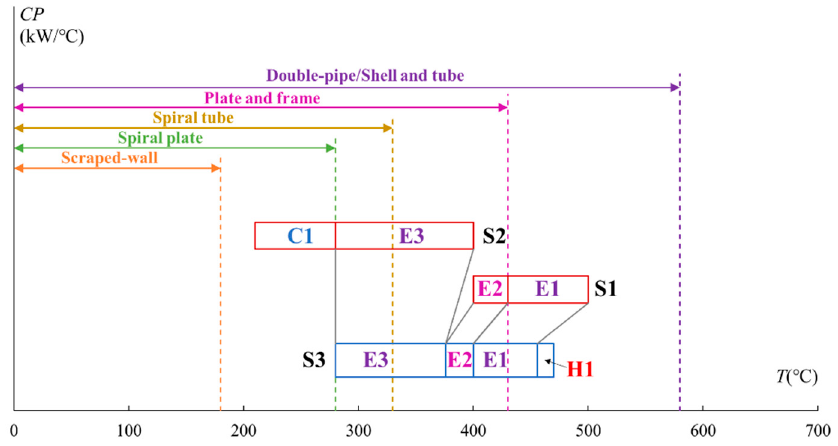
Figure 6. SRTGD-STR of the fourth retrofit plan for Example 1.